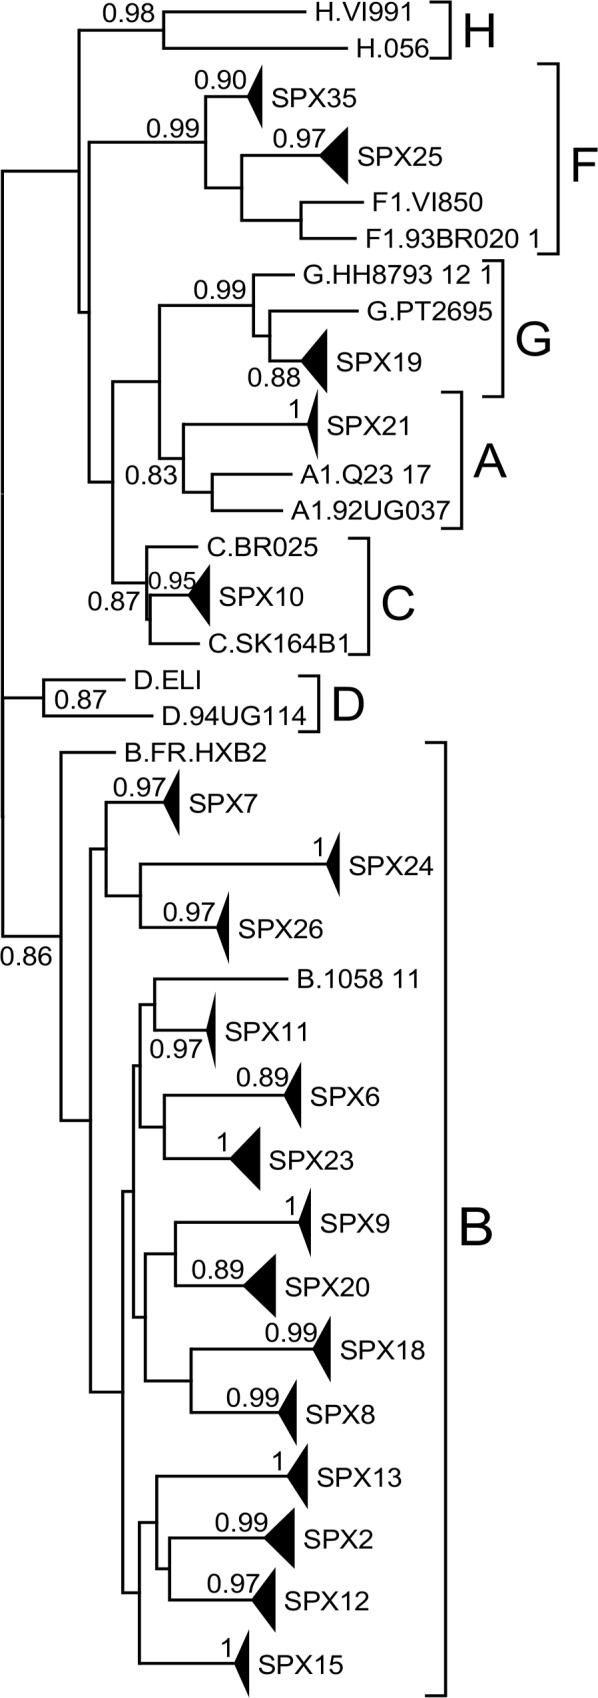
Phylogenetic tree of DS HIV-1 RNA sequences.The analysis was done with the fragment comprising exons 5 and 7 (HXB2 positions 5977–6045; 8379–8533), common to all DS transcripts, using 20 randomly chosen sequences per sample. Clades comprising sequences from each sample are compressed in triangles. SH-like node support values for sample clades and for subtype clades are shown.